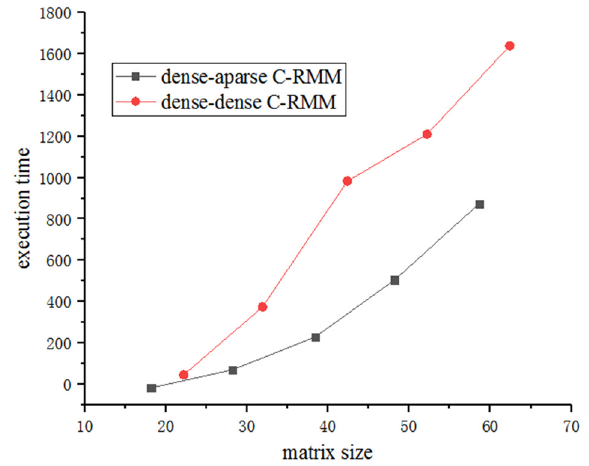
Figure 6: The performance of distributed dense - sparse matrix multiplication varies with